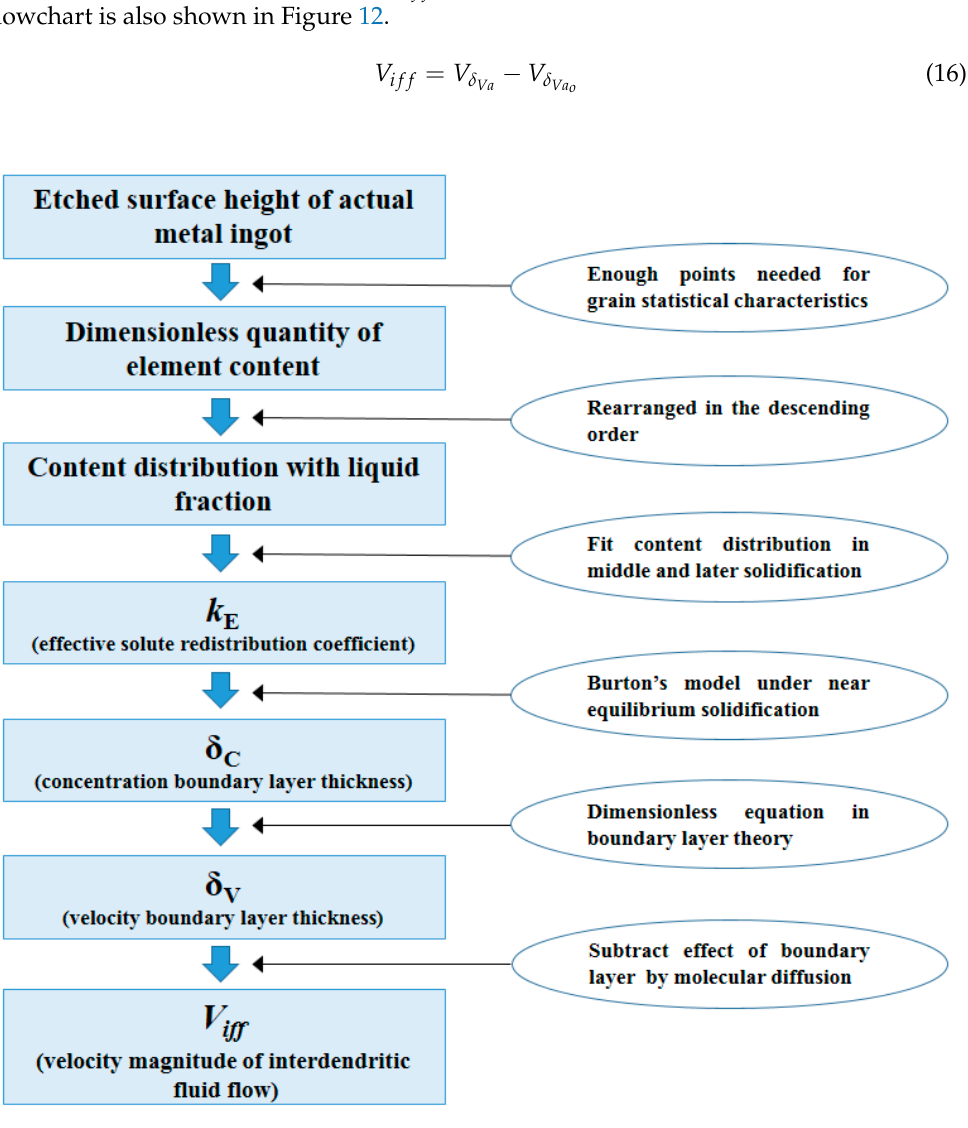
V using the iff